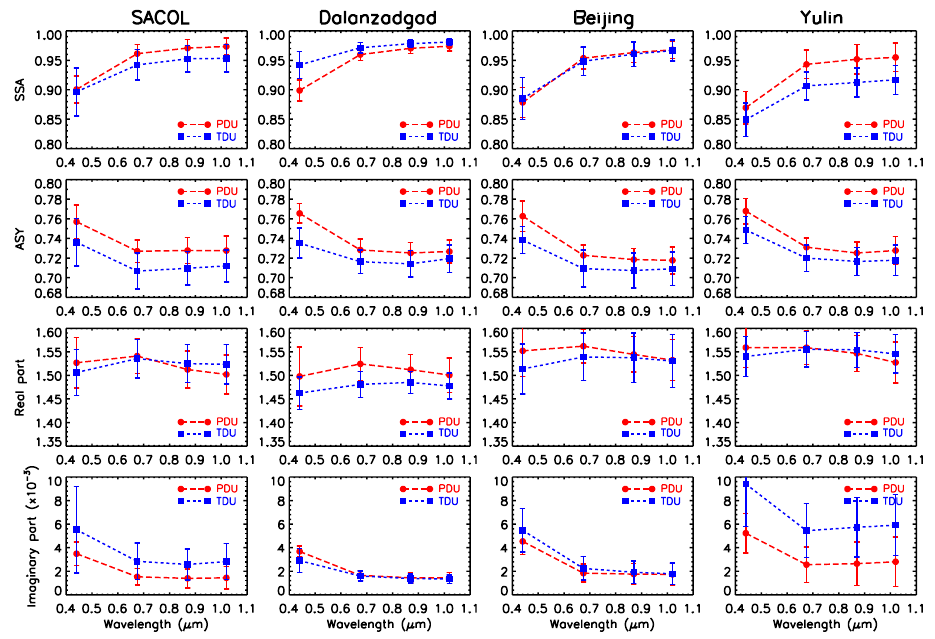
Figure 3. Overall average spectral behavior of key optical properties for Pure Dust ( α <0.2, PDU with red circle) and Transported Anthro- pogenic Dust (0.2< α <0.6, TDU with blue square) at four selected East Asian sites (SACOL, Dalanzadgad, Beijing, and Yulin). The error bars indicate plus or minus one standard